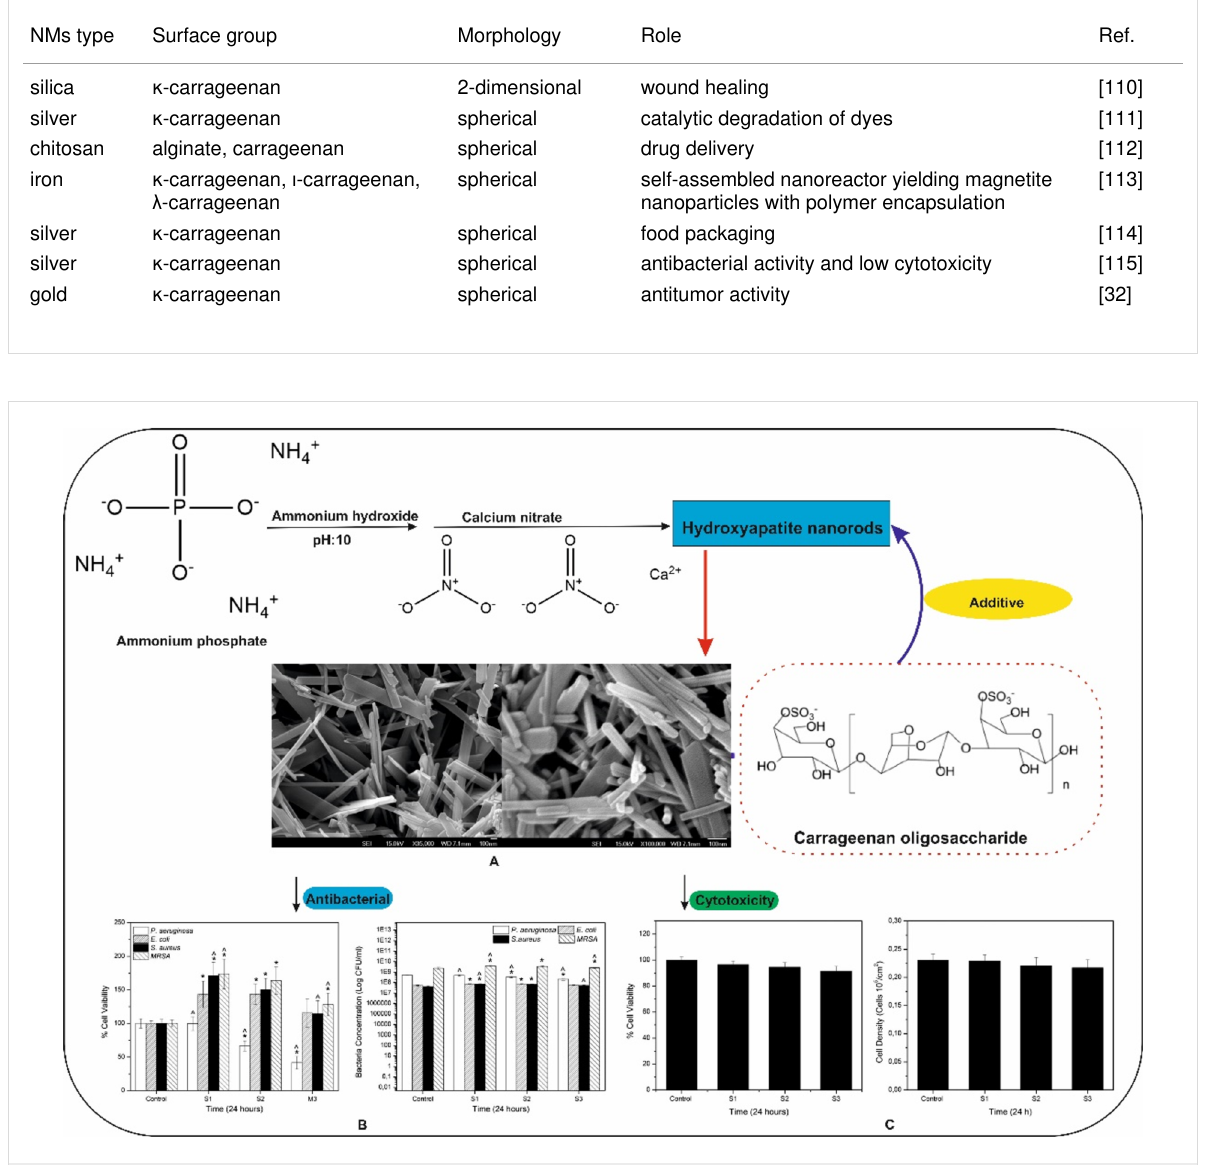
Table 3: The use of carrageenan in synthesizing various nanomaterials (NMs) for potential chemical and biological applications.